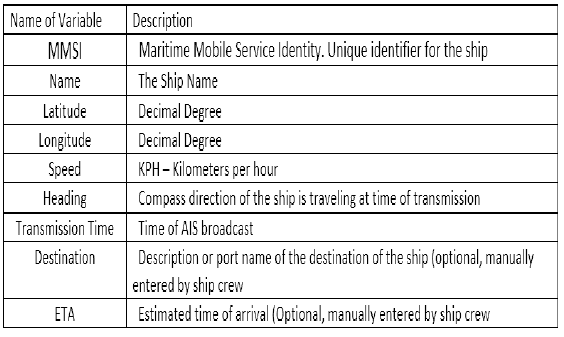
Table 2. Variables in maritime Automatic Identification